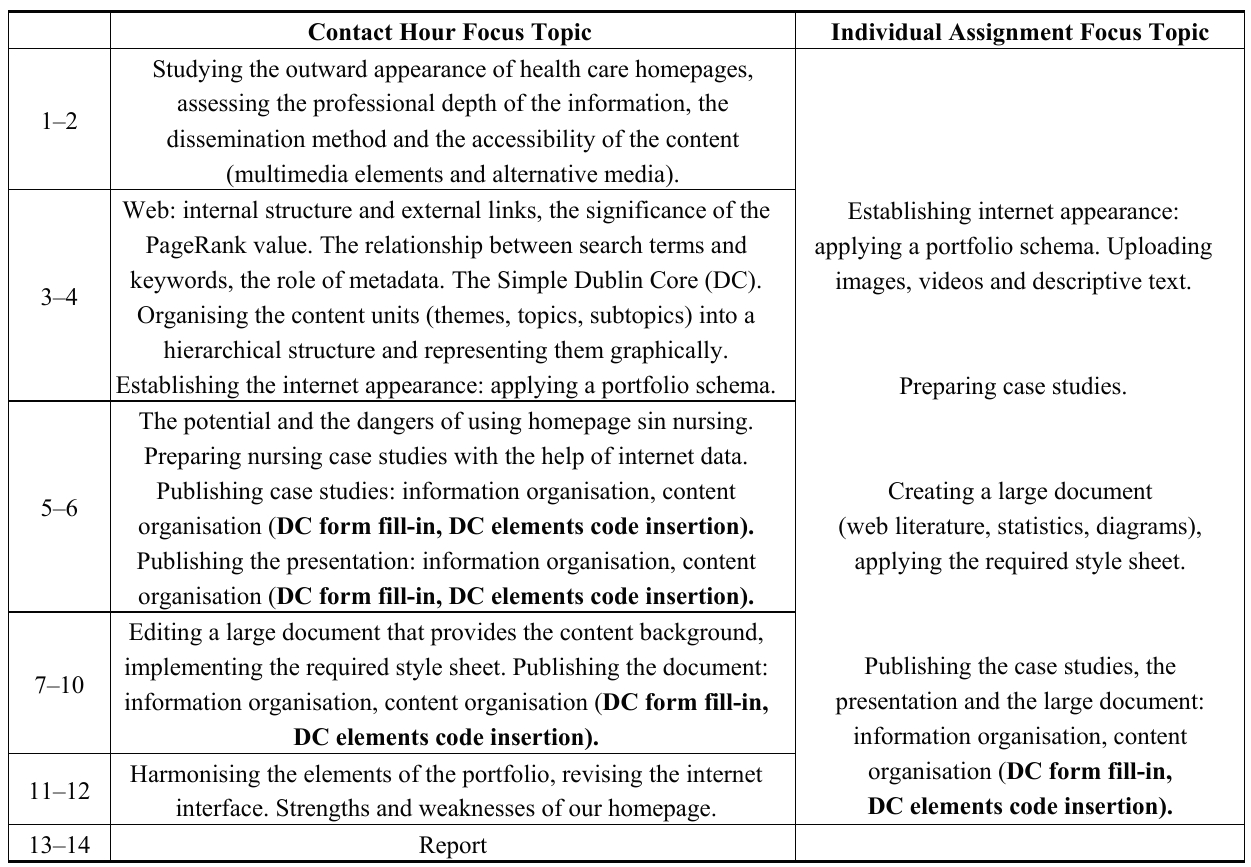
Table 3. The schedule of the 6th